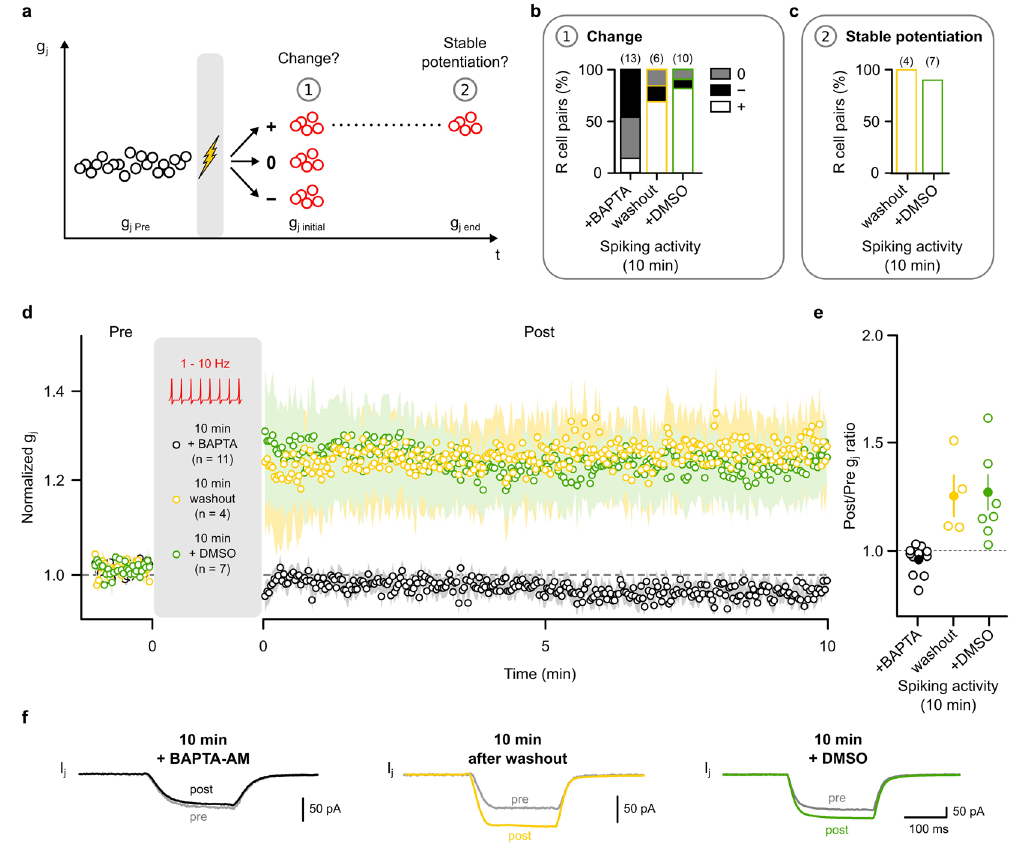
Figure 4. Activity-dependent LTP is dependent on intracellular calcium. ( a ) The average g j of the first 5 trials (g j initial ) after the spiking phase was determined to form three categories: potentiation ( + ; g j initial > mean g j + SD − ; g < mean g − SD Pre Pre ), depression ( j initial j Pre Pre ) and no change (0). The average g j of the last 5 trials of the 10 min observation period (g j end ) was determined to test if the initial change was stable (i.e. if g j end > g j initial − SD initial ). ( b ) Proportion of R cell pairs with potentiated (white), depressed (black) or unchanged (grey) g j initial subsequent to a 10 min period of spiking in presence of either BAPTA-AM in the external solution (50 µ M in DMSO), the solvent alone and after washout of BAPTA-AM. ( c ) Proportion of R cell pairs in which an initial potentiation was stable. ( d ) Averaged normalized g j (mean ± SEM) before and after spiking activity (10 min) in the majority of R cell pairs. In the presence of BAPTA-AM these were the ones with no change in g j initial, after washout of BAPTA-AM or in presence of DMSO these were the ones with an initial increase of g j . ( e ) Ratio